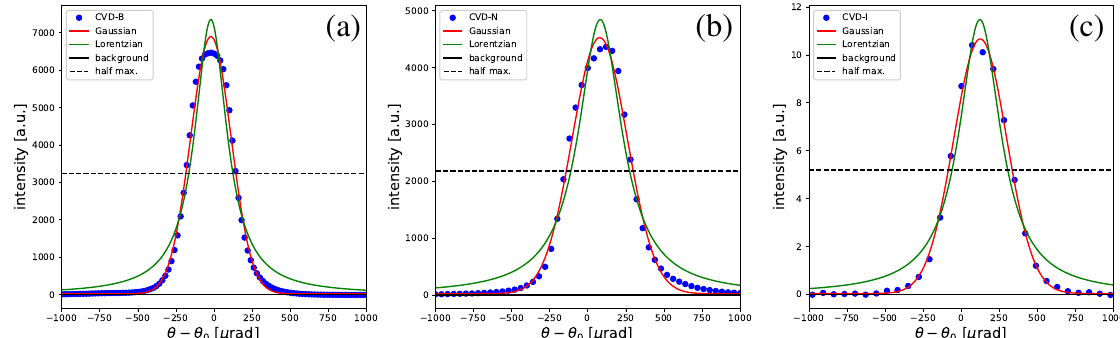
Figure A3. Total rocking curves for the regions of interest showing data points, fits to the Gaussian and Lorentzian shapes for plates: ( a ) CVD-B, ( b ) CVD-N, and ( c ) CVD-I. The dashed horizontal line shows the level corresponding to 1/2 of the rocking curve peak